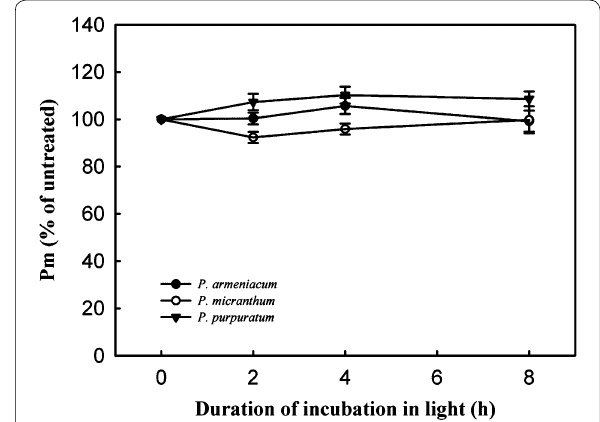
Fig. 3 Maximum photo‑oxidizable P700 ( P m ) during chilling treatment at 4 °C under photosynthetic flux densities of 500 μmol photons m − 2 s − 1 in three species of Paphiopedilum. Mean calculated from six independent plants per